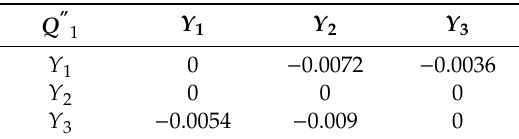
Table 30. The regret matrix Q (cid:48)(cid:48) 1 .